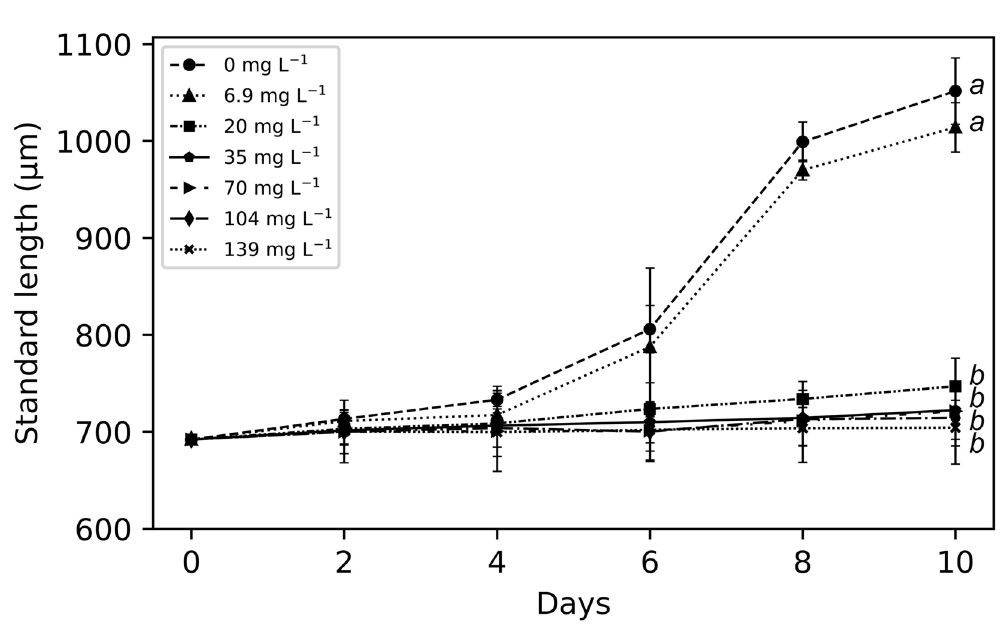
Figure 4. Growth comparison of elaphocaris larvae at different particle concentrations. Different letters at the right indicate significant differences ( p < 0.05) among treatments after 10 days of